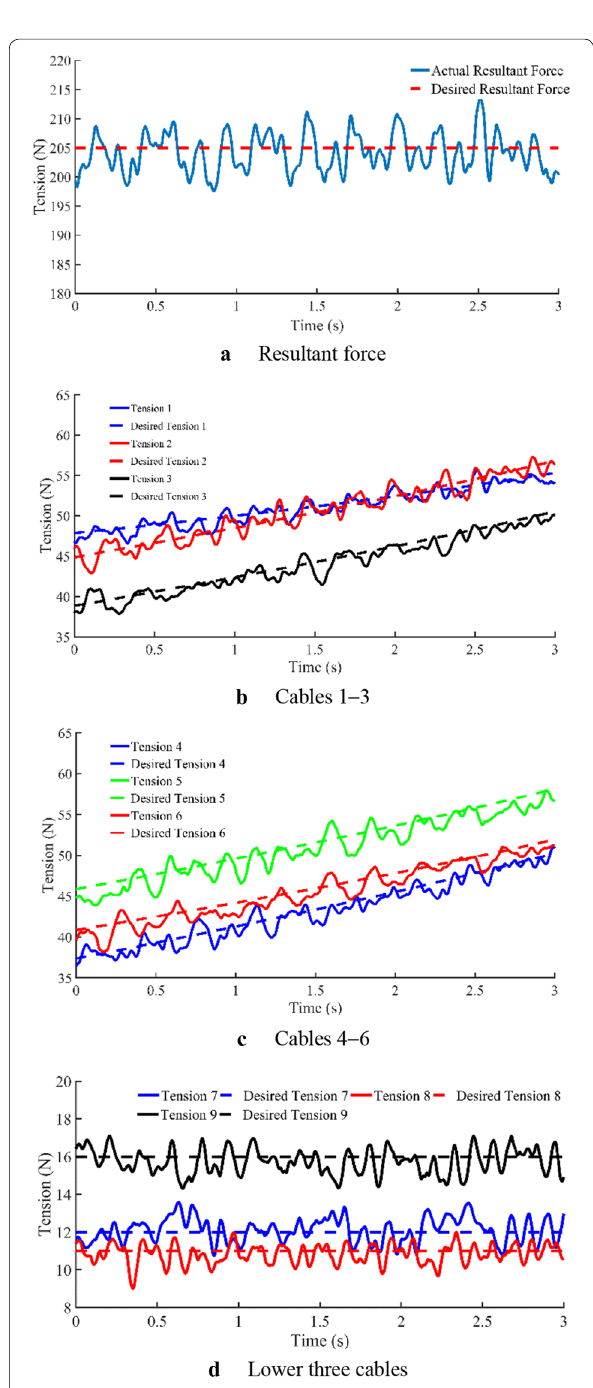
Figure 12 Results of constant vector force output experiments